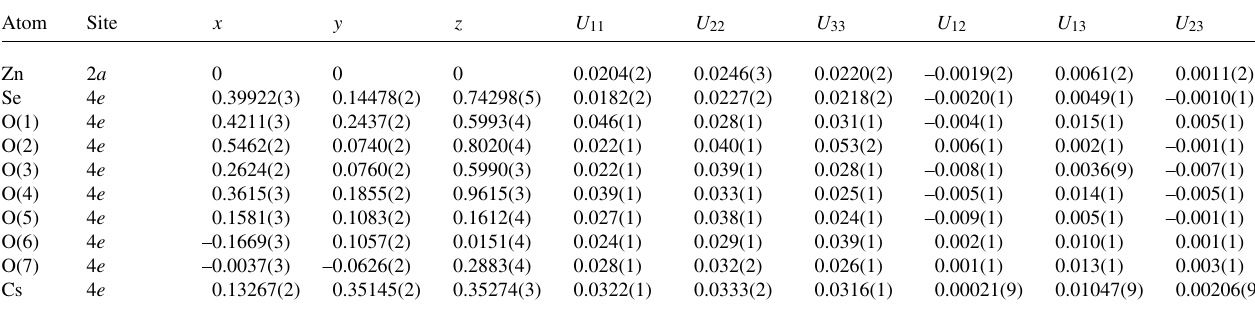
Table 15. Atomic coordinates and displacement parameters (in Å 2 ) .